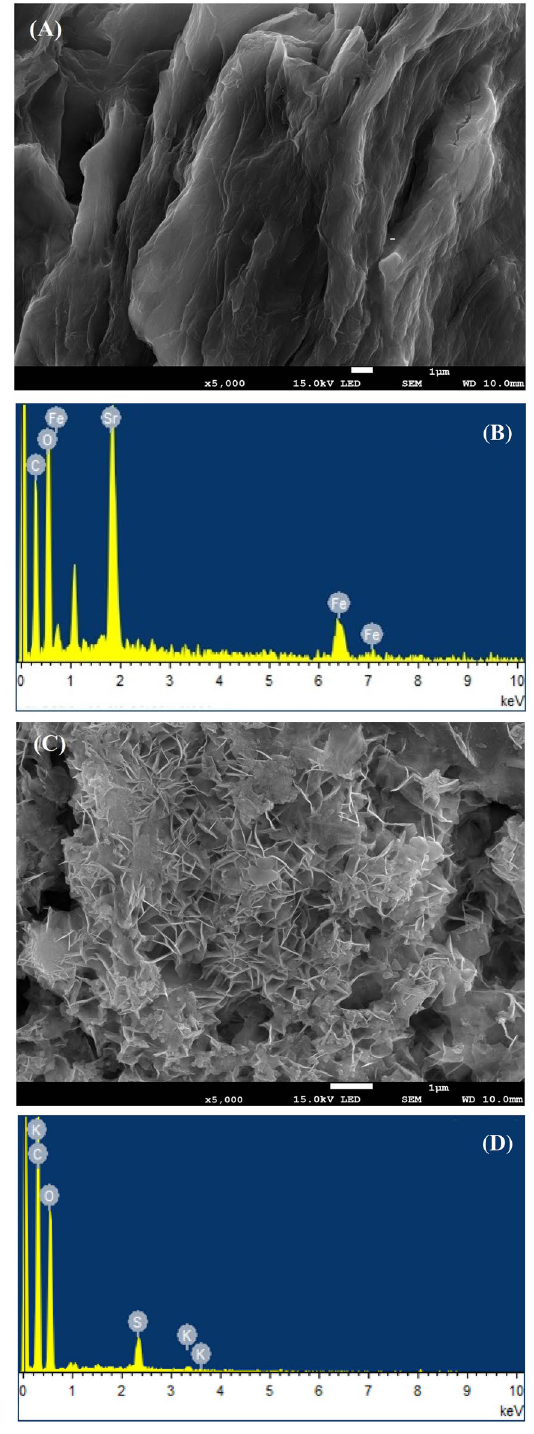
Figure 3. SEM images of GO ( A ), EDX of GO ( B ), SEM of SF@GOC ( C ), EDX of SF@GOC ( D